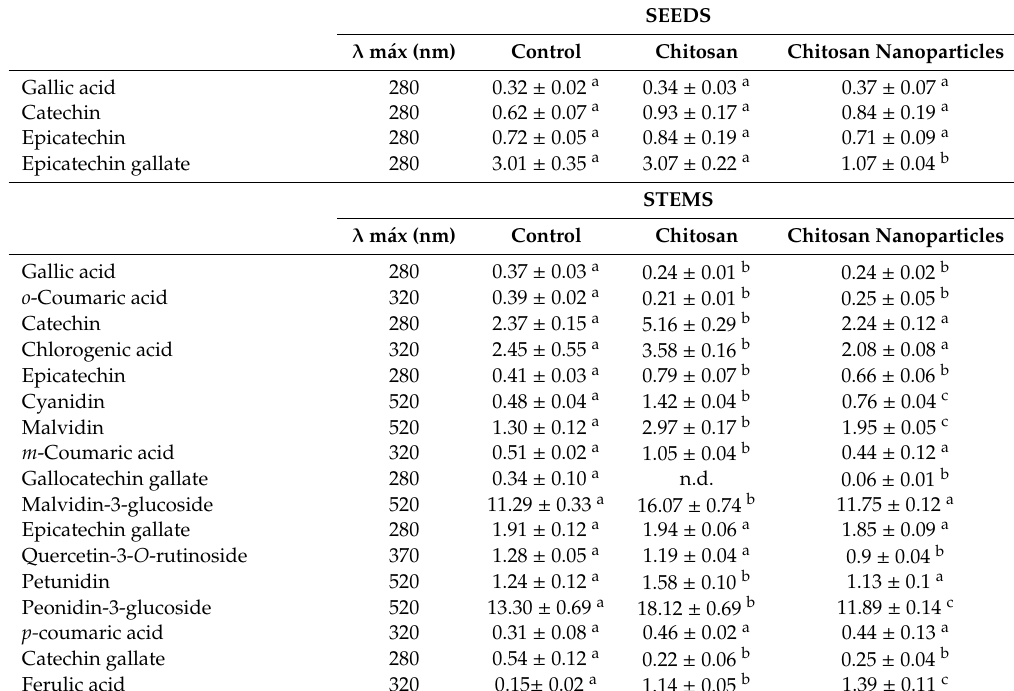
Table 2. Polyphenolic compounds ( µ g / mg of residue) found in grape skins, seeds and stems of Sous ã o variety with no treatment (control), treated with chitosan and with chitosan nanoparticles (mean ± SD, n =